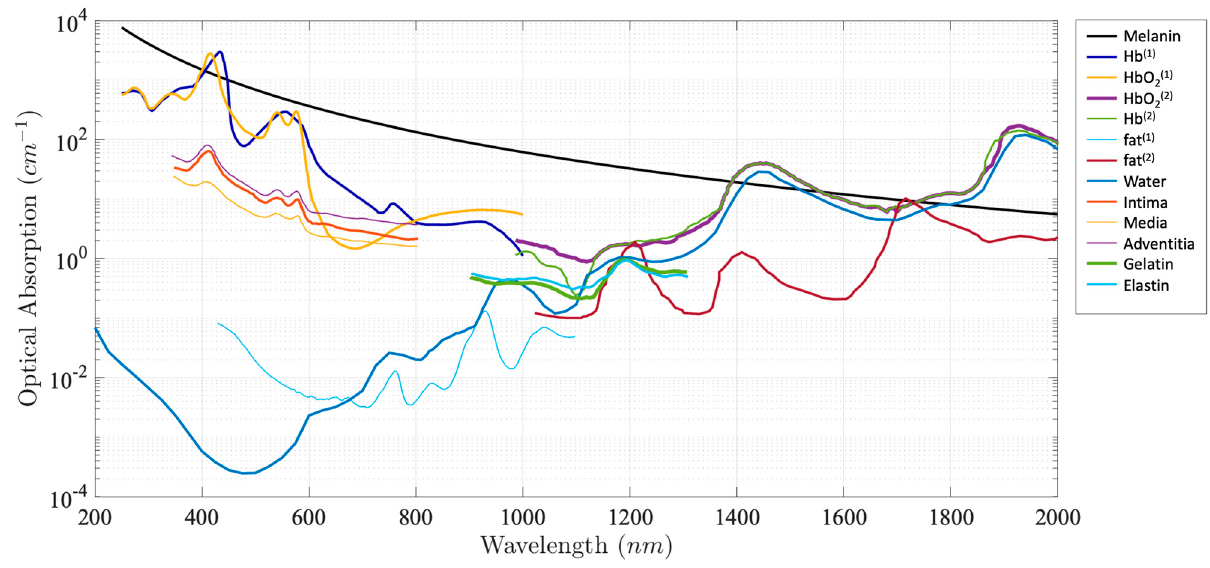
Figure 1. Absorption coefficient spectra of endogenous tissue chromophores [30–33].